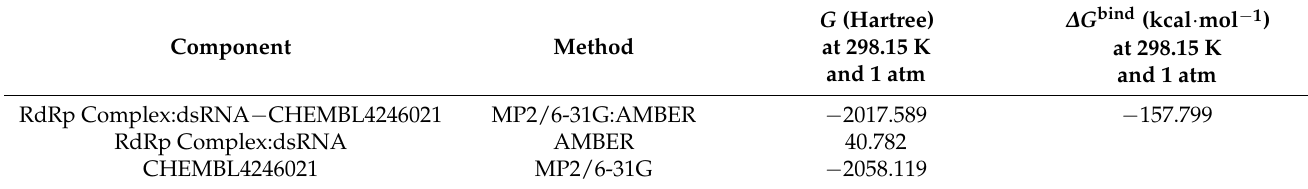
Table 1. Binding free energy between the RdRp complex:dsRNA and CHEMBL4246021 at 298.15 K in the gas phase.